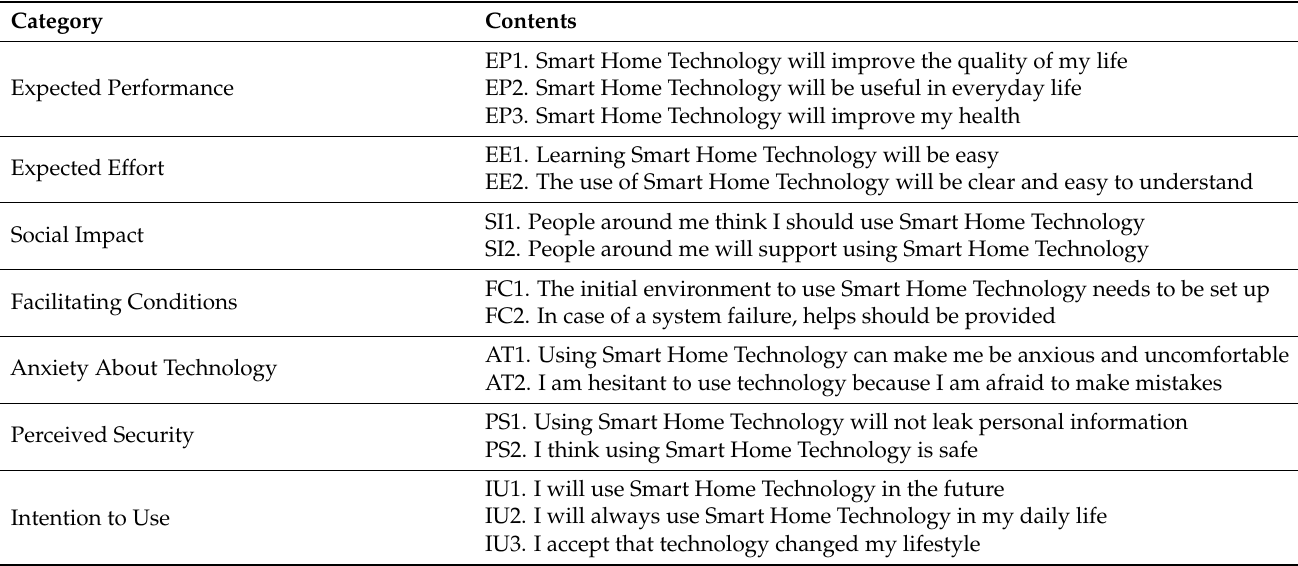
Table 1. Development of Measurement of Technology Acceptance Model